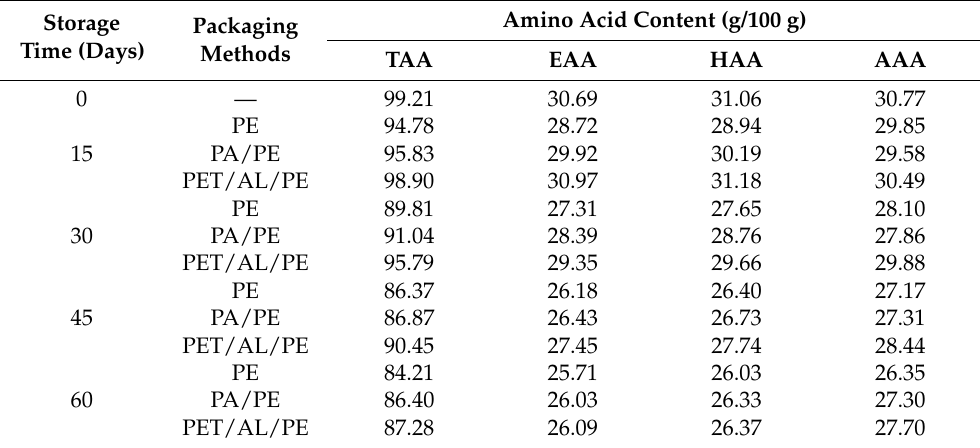
Figure 1. Amino acid composition analysis of walnut kernels with different packaging materials at 0, 15, 30, 45, and 60 days of storage (( A ) PE-sealed packaging; ( B ) PA/PE vacuum packaging; ( C ) PET/AL/PE vacuum packaging). Table 1. Amino acid composition analysis of walnut kernels with different packaging materials at 0, 15, 30, 45, and 60 days of storage (TAA is a total amino acid, EAA is an essential amino acid, HAA is a hydrophobic amino acid, and AAA is acidic amino acids).